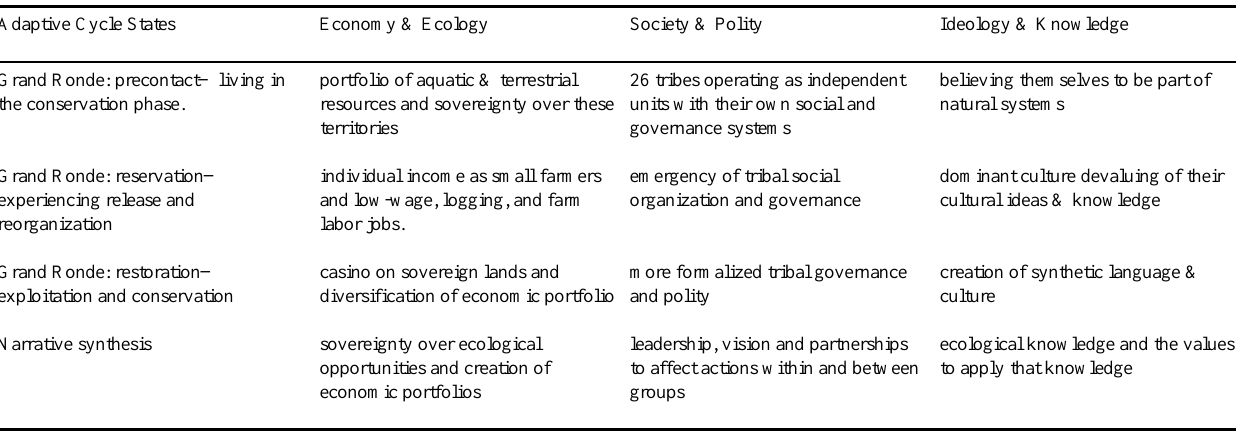
Table 2 . Comparisons of adaptive capacity elements with dimensions of Grand Ronde culture through adaptive cycle states from narrative